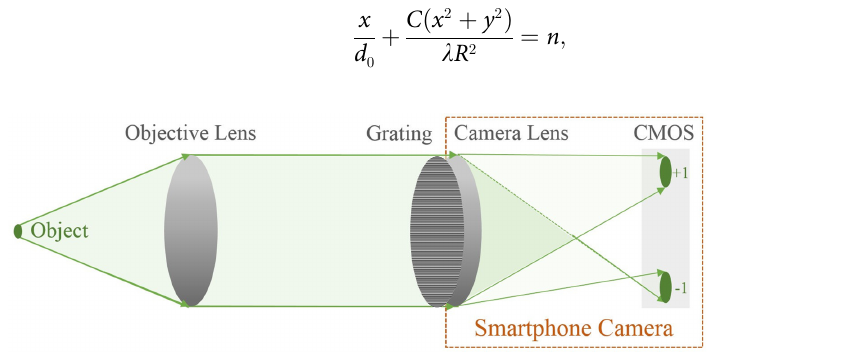
Fig 2. Smartphone-based wavefront sensor with extended system